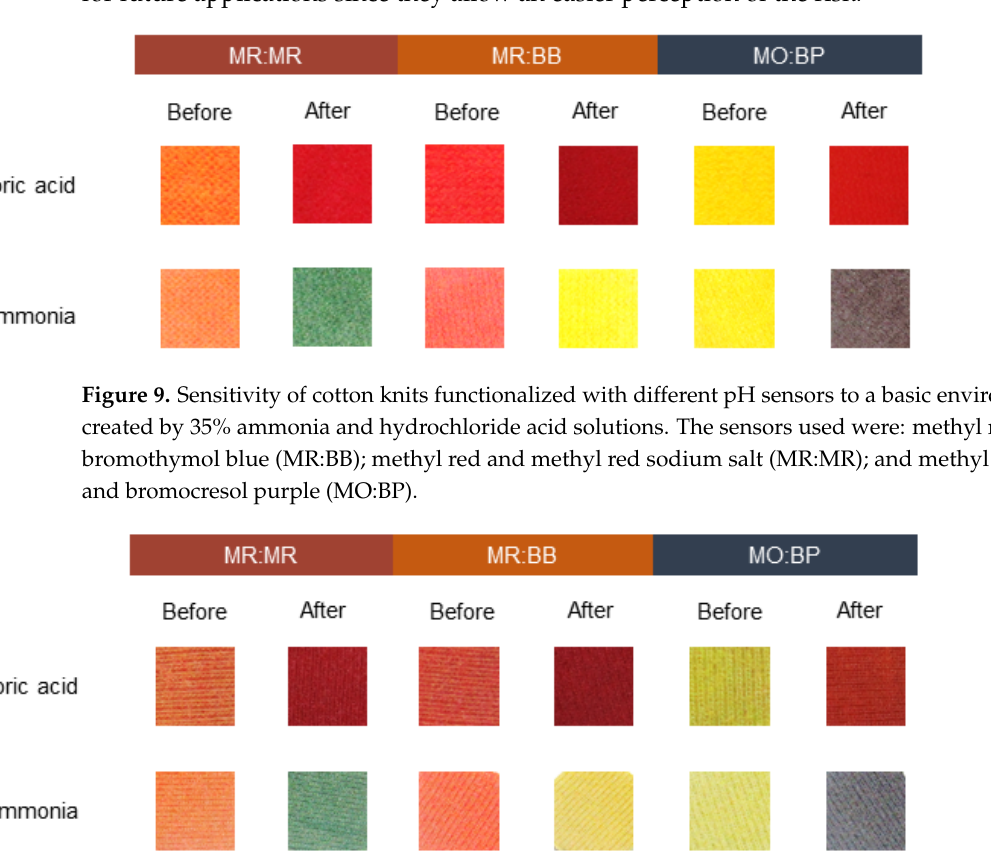
Figure 10. Sensitivity of polyester knits functionalized with different pH sensors to a basic environ- ment created by 35% ammonia and hydrochloride acid solutions. The sensors used were: methyl red and bromothymol blue (MR:BB); methyl red and methyl red sodium salt (MR:MR); and methyl orange and bromocresol purple (MO:BP).